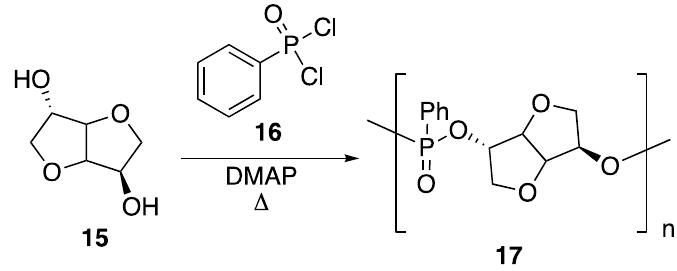
Figure 11. Synthesis of polyphosphonate 17.